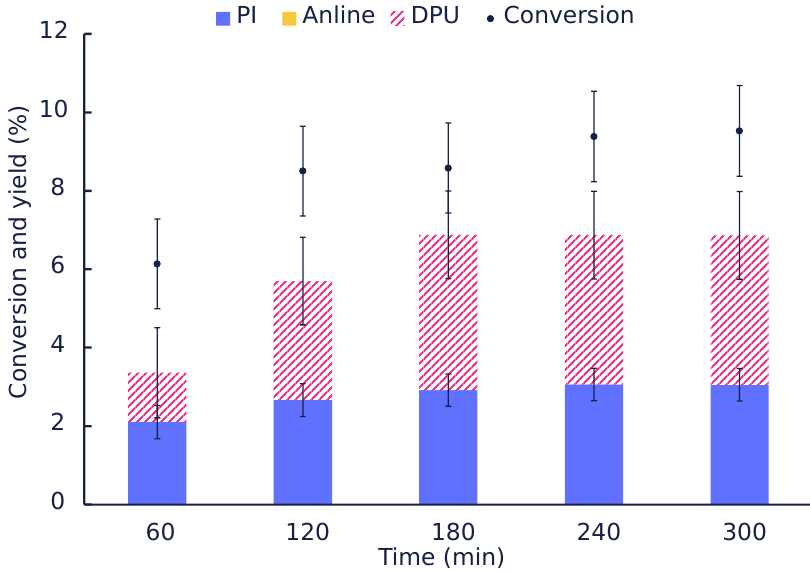
Figure 1. The non-catalytic conversion of MPC at 200 °C (8 wt% MPC in diphenyl ether). Negligible aniline was observed in these experiments.